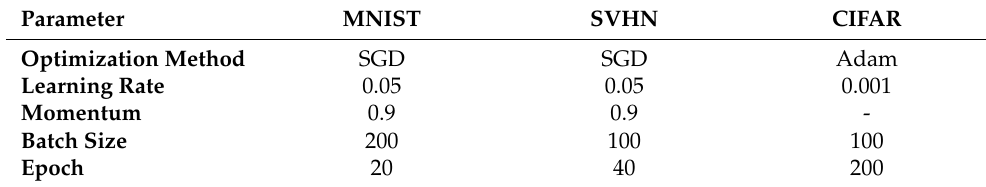
Table 1. Parameters set for training the